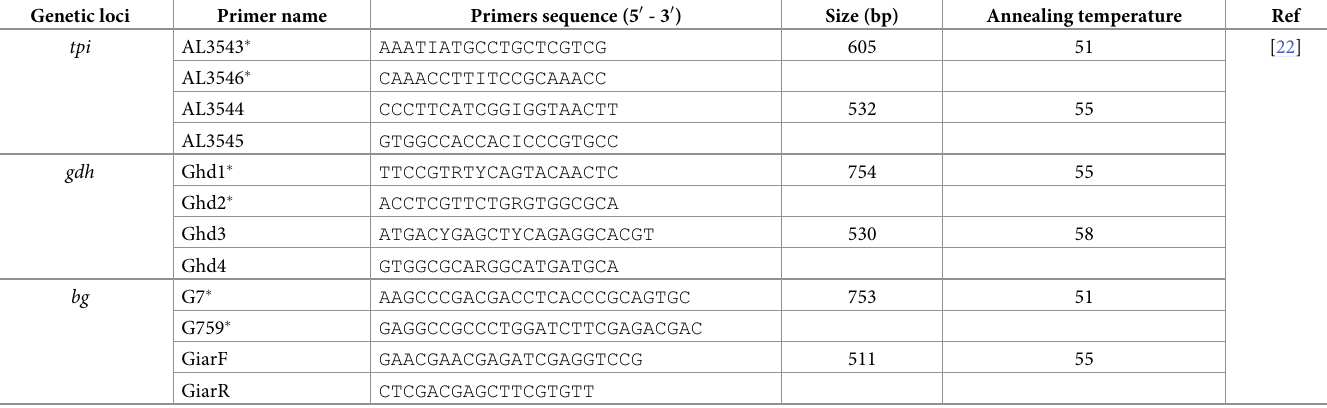
Table 1. Targets and primers used for PCR amplification of gdh , tpi and bg genes of G . duodenalis . Genetic